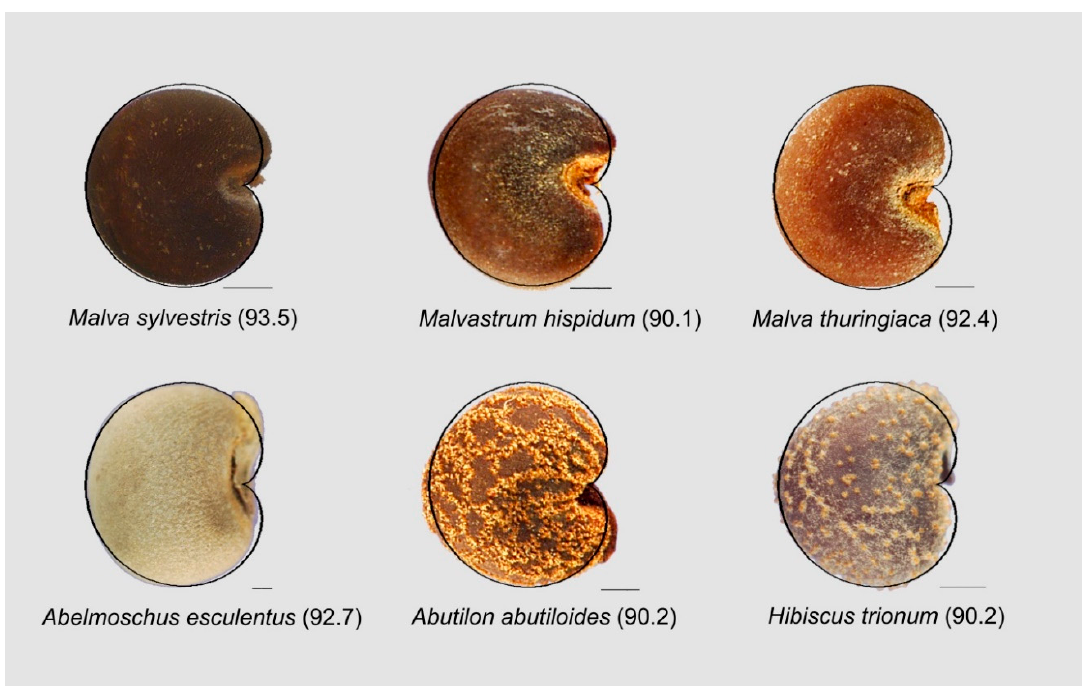
Figure 13. The cardioid is a model for seed shape description and quantification in species in the Malvaceae. All the species represented are herbs, except Abutilon, which is a sub-shrub. The values indicated correspond to J index in the images shown and do not mean values for each particular species. Bar equals 0.5 mm.